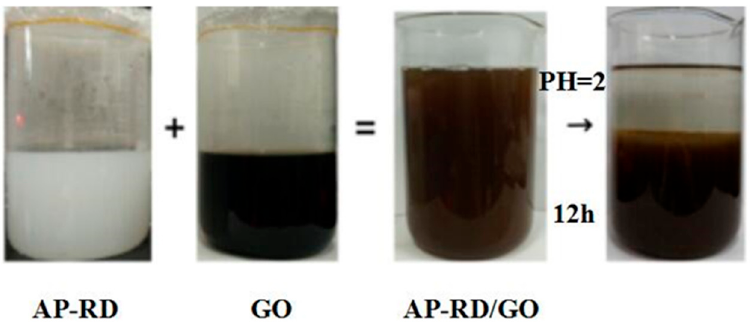
Figure 1. Pictures of solution of AP–RD, GO and AP–RD/GO. When the pH value of aqueous solution is 2, the AP–RD changes from negative to positive due to the interaction between proton and -NH 2 , and Zeta potential is 11.9 mV. The surface of GO was electronegative due to the presence of carboxyl groups, and Zeta potential was − 20.9 mV (Table 1). Table 1. Average particle size, PDI and Zeta potential of Laponite RD, AP–RD and GO.